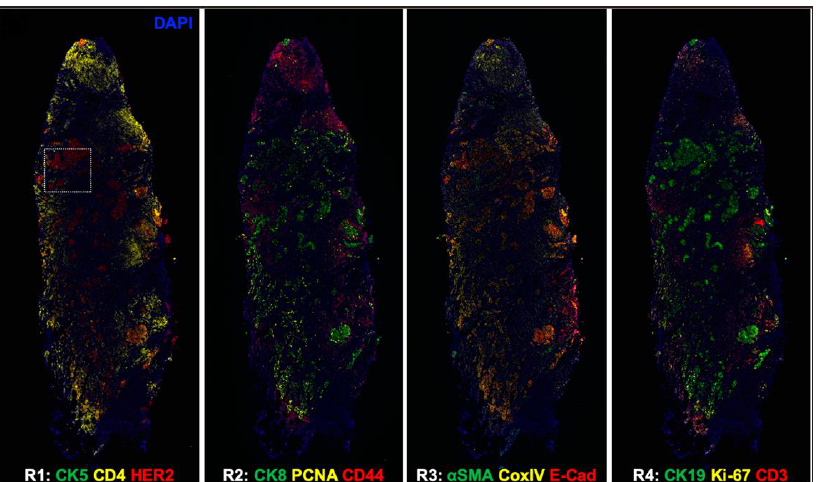
Figure 3. CycIF shows whole HER2 positive breast cancer tissue images. CK5, cytokeratin 5; CK8, cytokeratin 8; CK19, cytokeratin 19; PCNA, proliferating cell nuclear antigen; E-Cad, E-cadherin; α - SMA, α -smooth muscle antigen; CoxIV, cytochrome c oxidase. (Reprinted with permission from